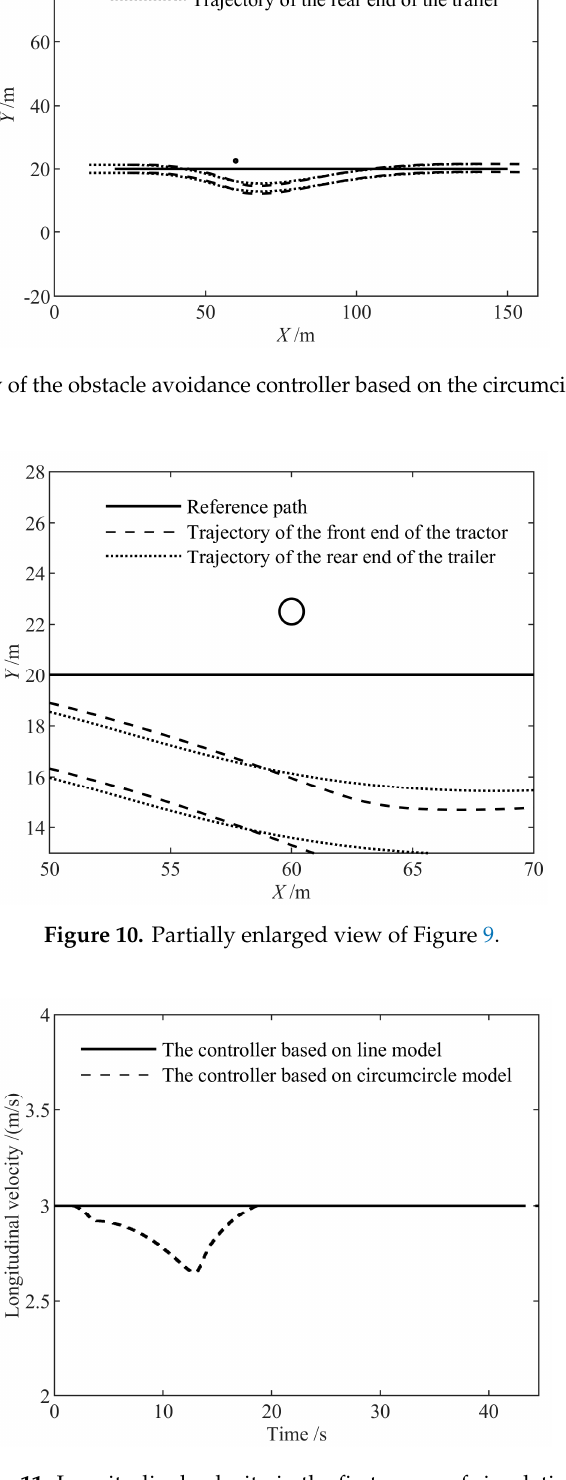
Figure 11. Longitudinal velocity in the first group of simulations.